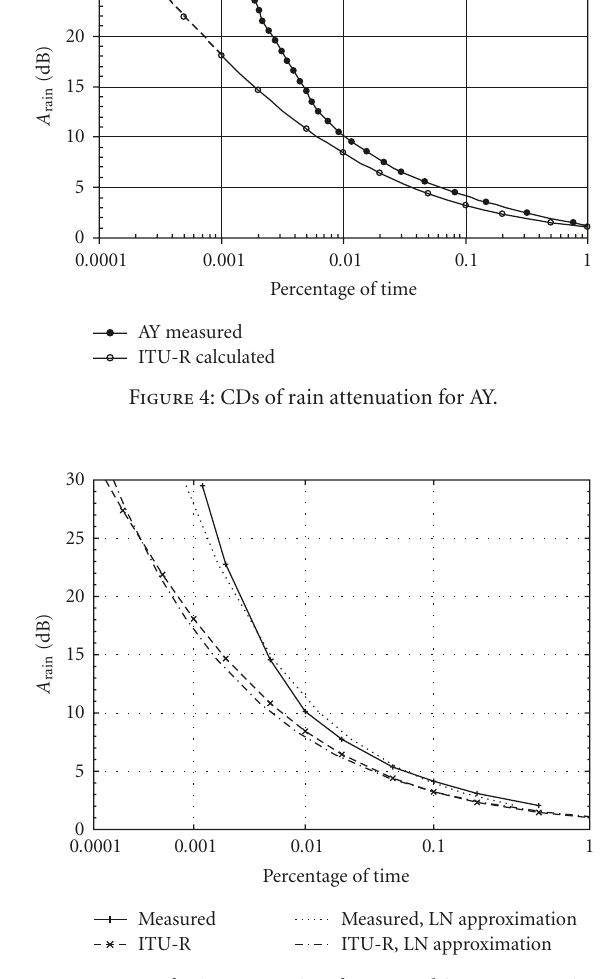
Figure 5: CDs of rain attenuation for AY and its LN approxima-